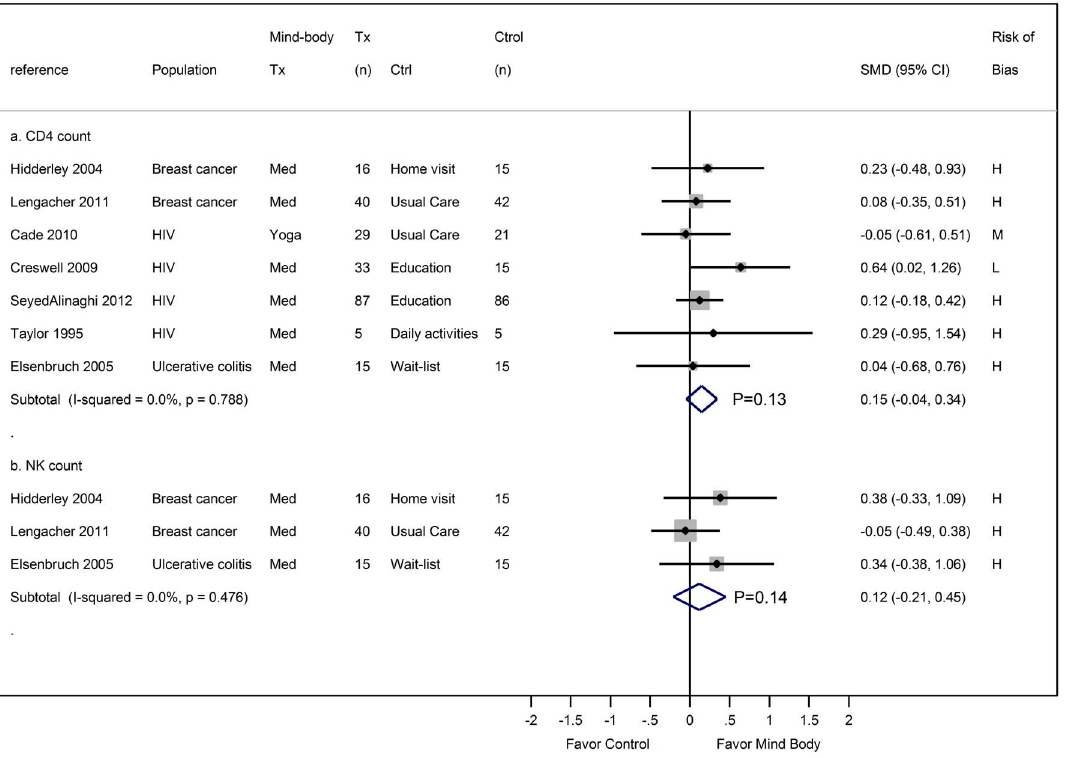
Figure 4. Meta-analysis of RCTs comparing the effect of mind-body therapies with control interventions on enumerative markers: CD4 count (panel a) and NK count (panel b). Legends: CD4=cluster of differentiation 4 protein; Med=meditation; NK count=natural killer cell count; Tx=treatment; SMD=standardized mean.